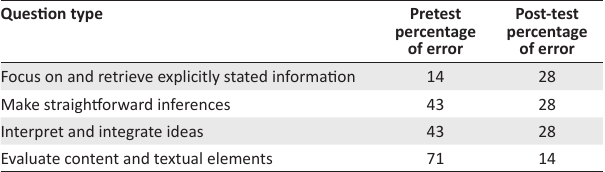
TABLE 3: Pre- and post-test comprehension